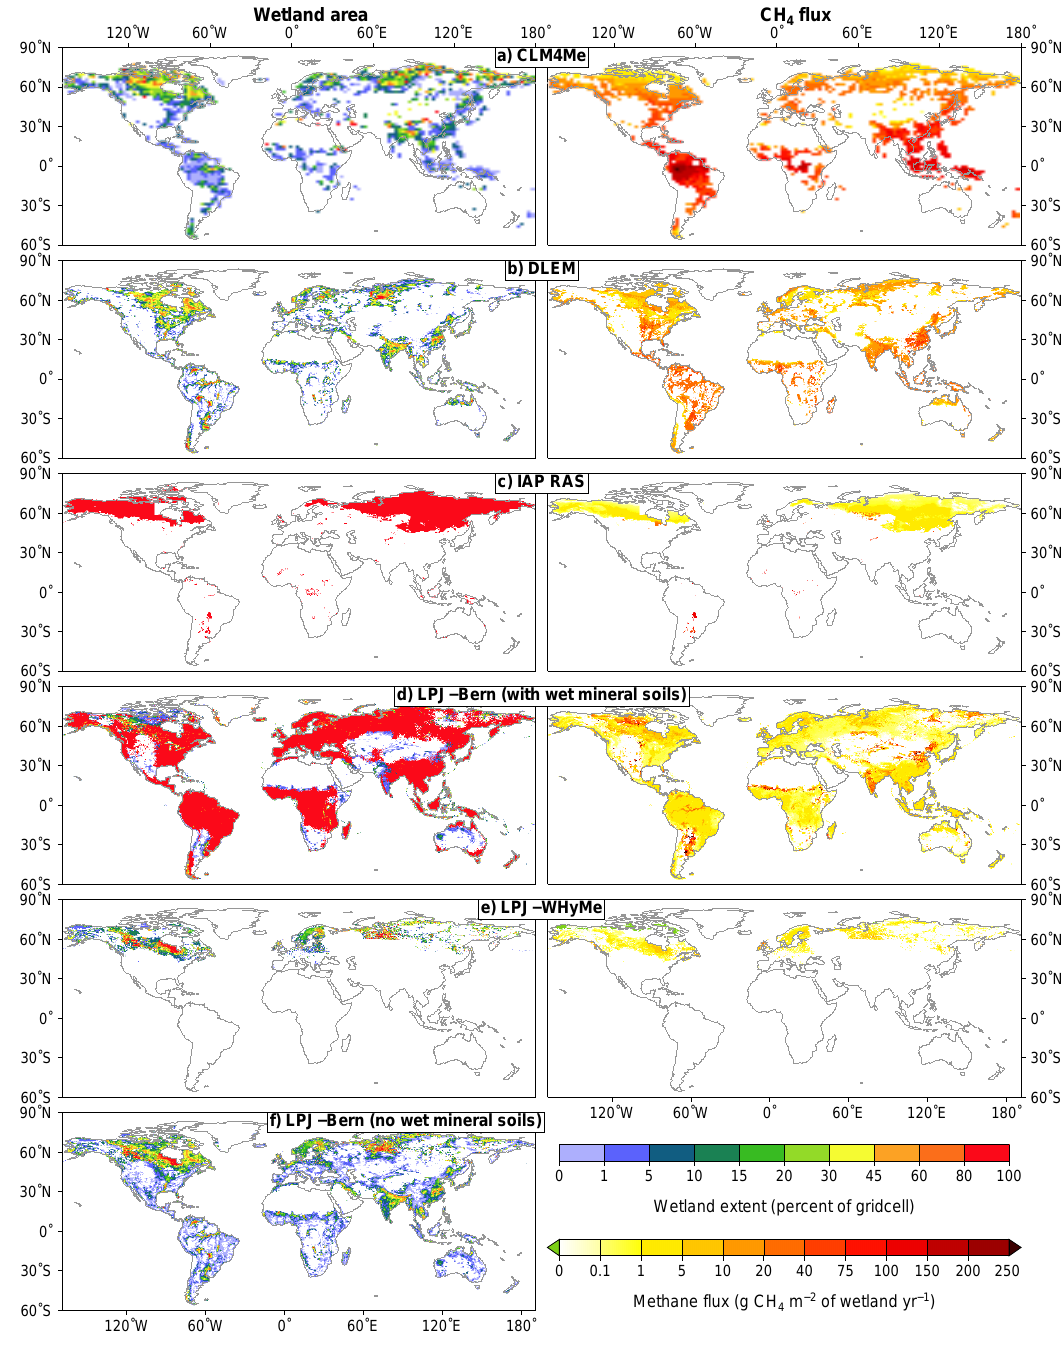
Fig. A1. Maximal wetland extent and mean annual CH 4 flux densities for Experiment 1 for all models.